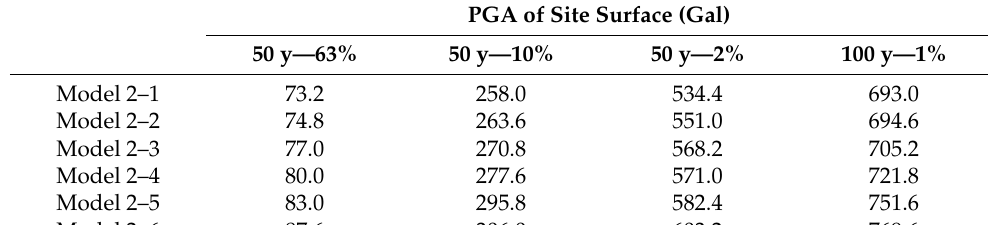
Table 4. The PGA of site surface under different silty clay layer thicknesses.